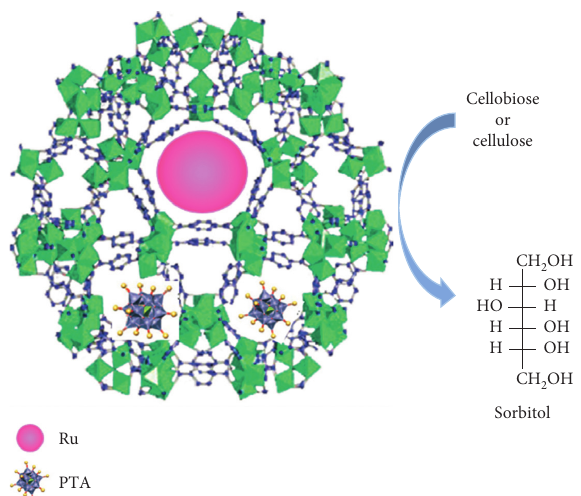
Figure 4: Metal-acid bifunctional catalyst